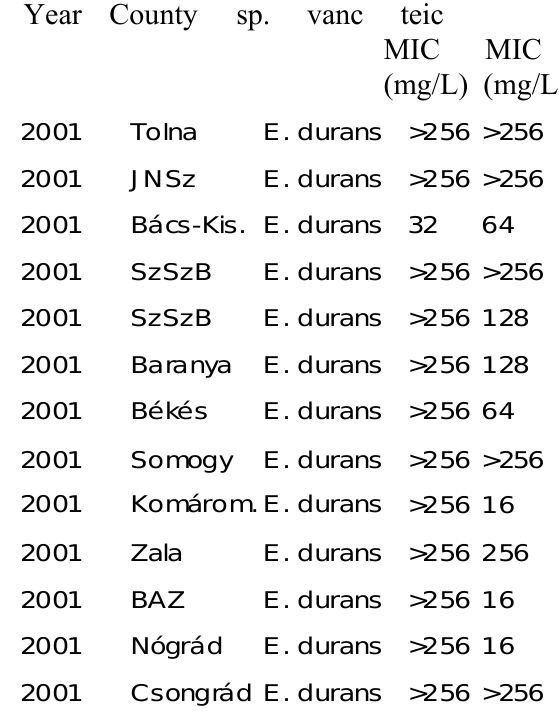
Dice (Opt:1.00%) (Tol 2.0%-2.0%) (H>0.0% S>0.0%) [0.0%-100.0%]